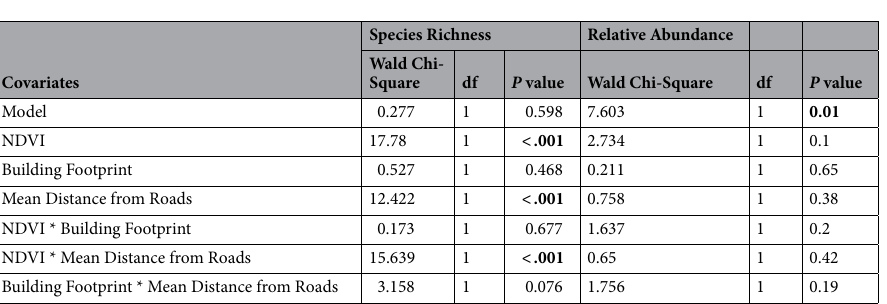
Table 2. Generalized linear mixed methods (GLMM) regression